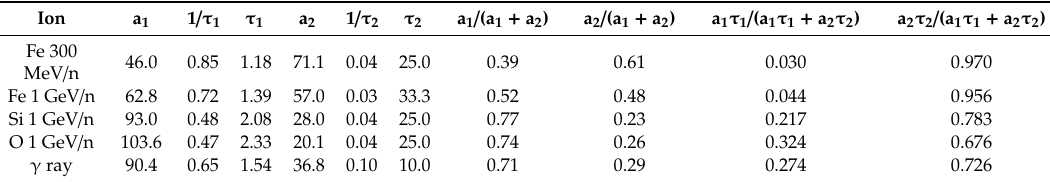
Table 1. Bi-exponential